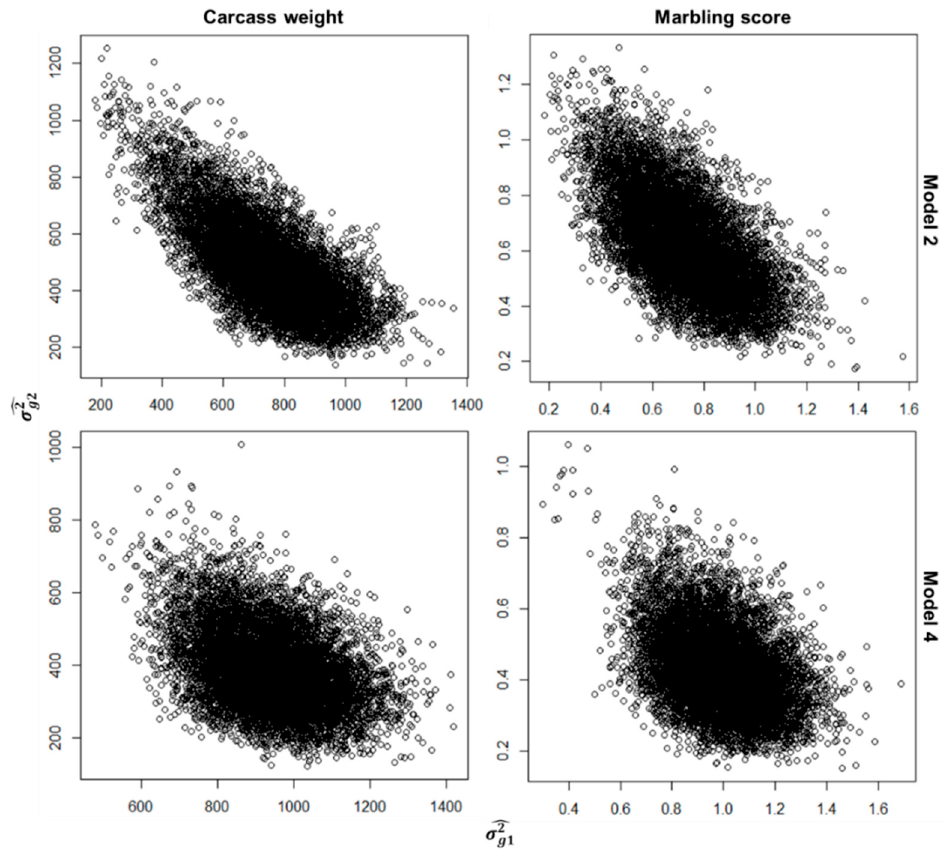
Figure 2. Scatter plots of 10,000 posterior samples for two variance components, 𝜎 (cid:3034)(cid:2869)(cid:2870) and 𝜎 (cid:3034)(cid:2870)(cid:2870) , in models 2 and 4.